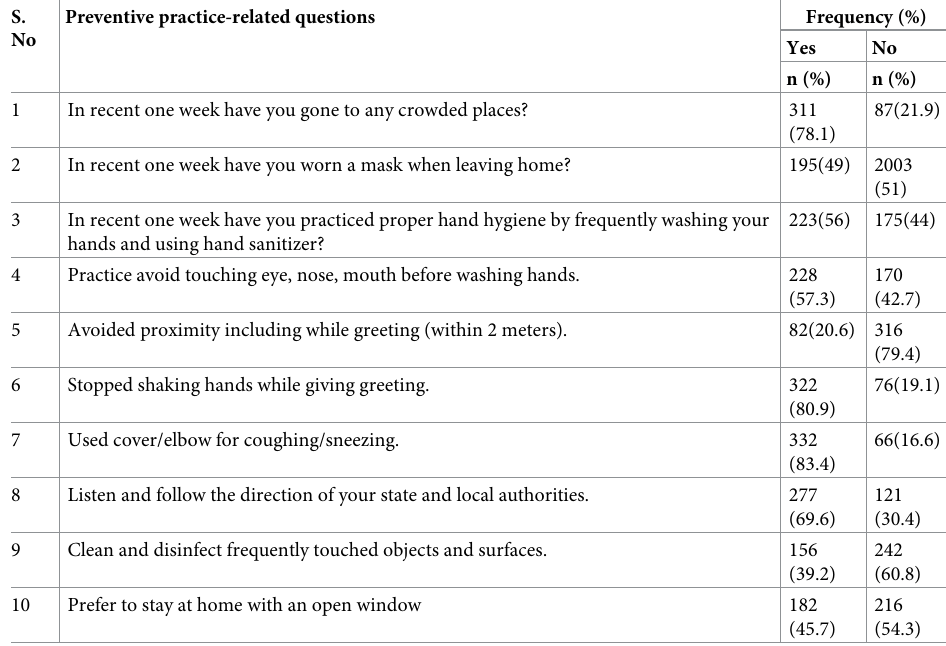
Table 6. Practice of preventive measure towards COVID-19 among outpatient service visitors at Debre Markos comprehensive specialized hospital, Amhara regional state, Ethiopia, 2020. S.